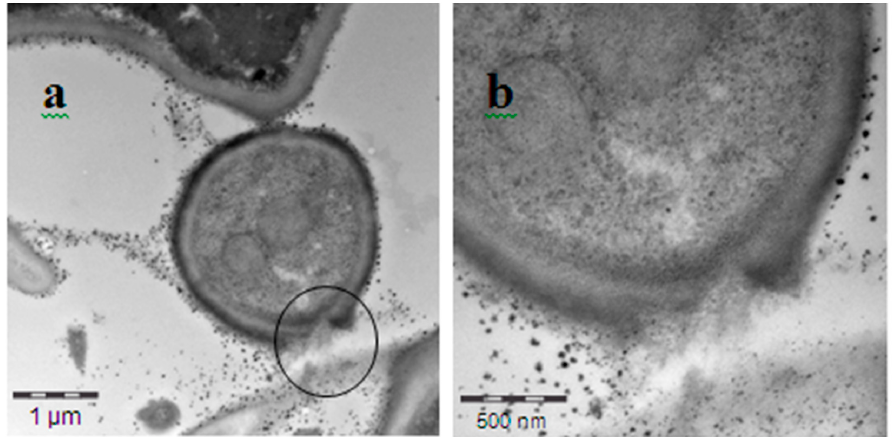
Figure 3. A section of fungal hyphae of M. fijiensis in the intracellular space of the mesophyll tissue of Timorex Gold-treated banana leaves: ( a ) at low magnification (×8000); and ( b ) at high magnification (×50,000). Note the disruption and breakdown of the cell wall. Agronomy 2020 , 10 , x FOR PEER REVIEW